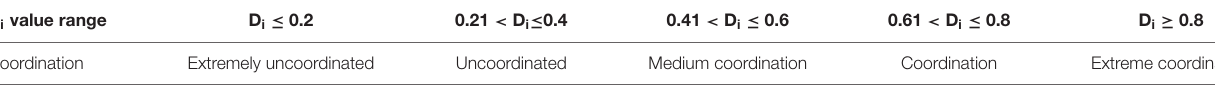
TABLE 3 | Value range and significance of coordination